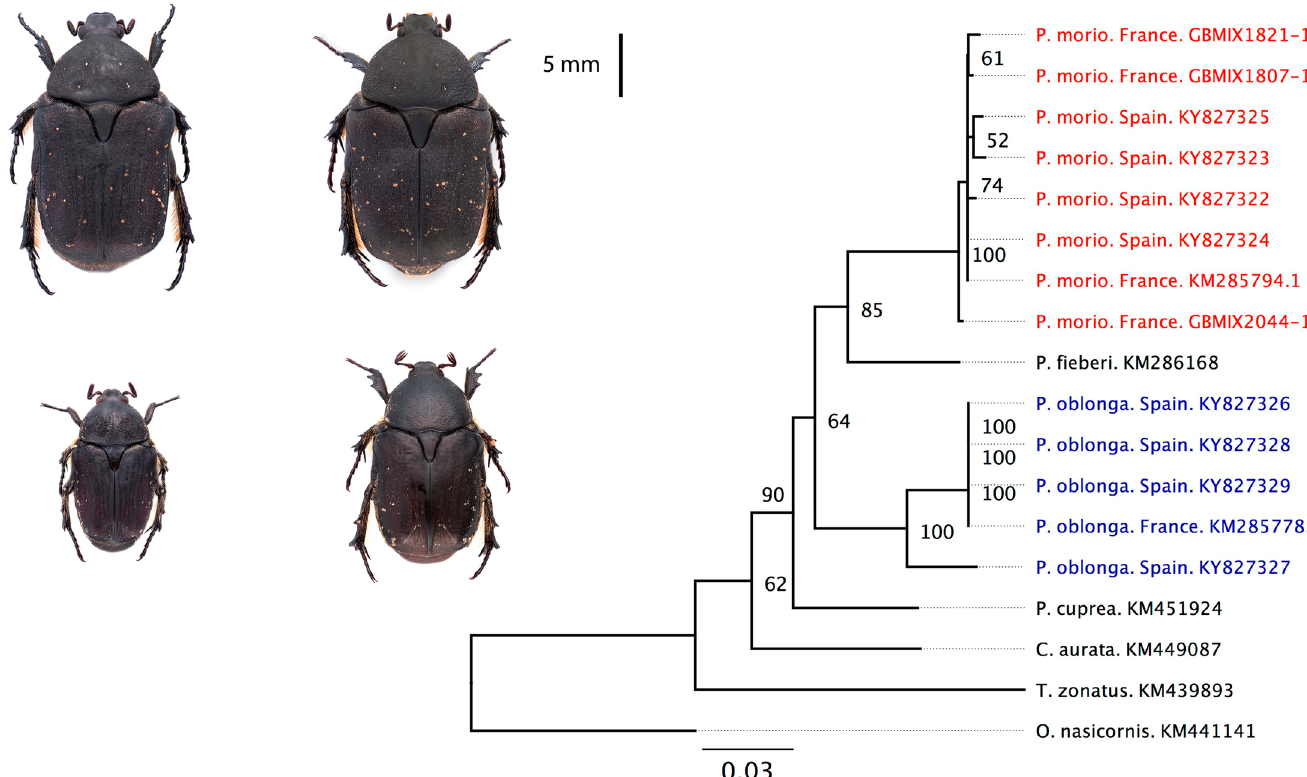
Fig 2. The two species considered ( Protaetia morioP . oblonga ) and the Neighbour joining tree of the specimen considered. Left: Protaetia morio (upper) and P . oblonga (lower), showing male (left) and female (right) individuals. Right: Neighbour joining tree of the specimen sampled (those from Spain) plus those obtained from the GenBank and BOLD, including the genus Protaetia , Cetonia , Trichius and Oryctes .For details on the methods, see S1 Appendix; for details of the species, see S2